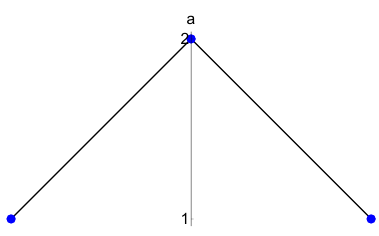
Figure 1 . Homological diagram for 3 1 knot. Each dot represents one homology generator or a monomial in the superpolynomial. Horizontal and vertical axes encode respectively q -degrees and a -degrees of